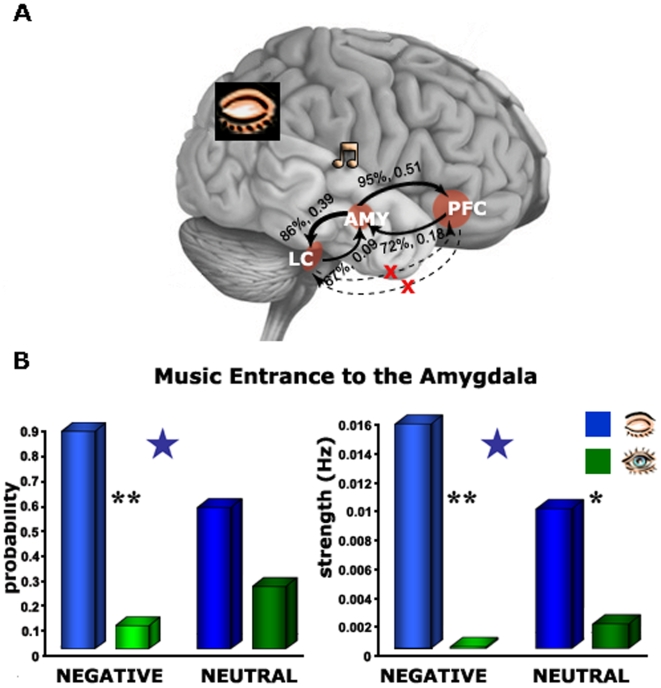
DCM – model and connectivity.(A) directions of the connectivity between the amygdala, PFC and LC during eyes closed. (B) The power of intrinsic connections indicated by probability and strength. Note the most probable and the strongest connection from the amygdala toward the PFC. *, p<0.01, **, p<0.001. Blue stars indicate a significant difference between the valences under closed eyes state (p<0.05).